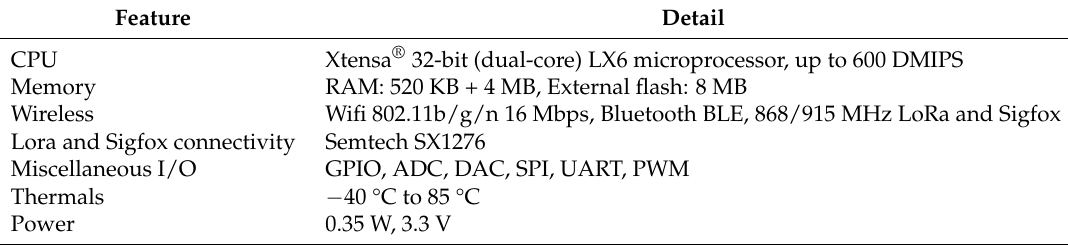
Table A2. Specifications of the Pycom LoPy